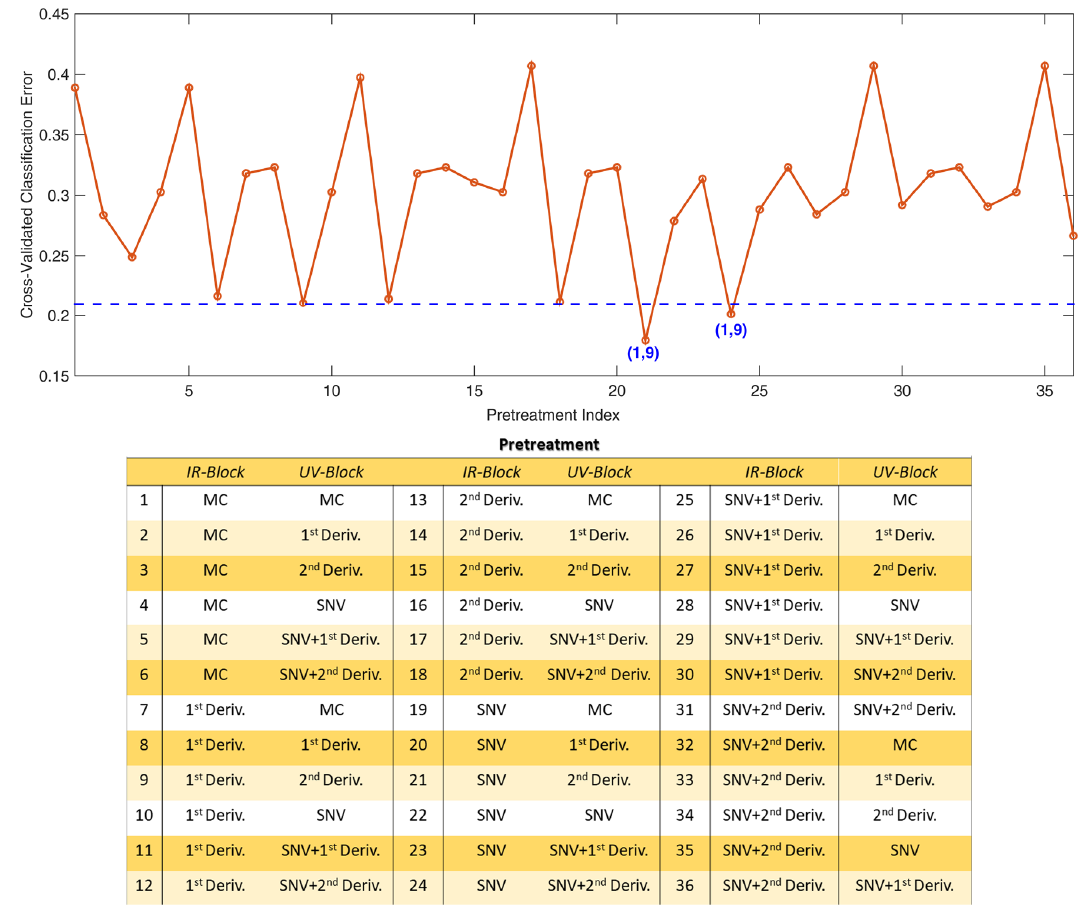
Figure A2. SO-CovSel-LDA Cross-validated Classification errors. Numbers in brackets represent the number of variables selected in the IR and the UV-Vis blocks, respectively. The dashed line is not a cut-off value, it is meant to help the appreciation of the local minima. In the table, “MC” stands for “mean centering” and “Deriv.” for “derivative”.